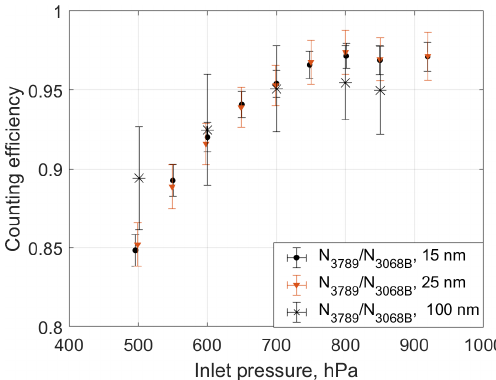
Figure 3. The vWCPC 3789 counting efficiency as a function of the inlet operation pressure at TSI standard conditions: T cond = 30 ◦ , T ini = 59 ◦ , and T mod = 10 ◦ C. N 3789 /N 3068 B is the total number concentration ratio between the vWCPC and the